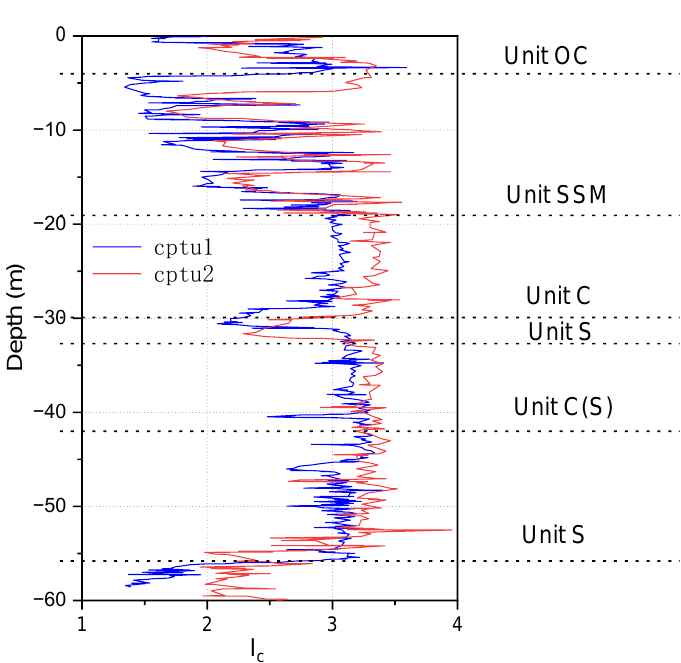
Figure 1. The normalized CPTU test result. ( a ) Norm cone resistance, ( b ) Norm friction ratio, ( c ) Norm pore pressure ratio.